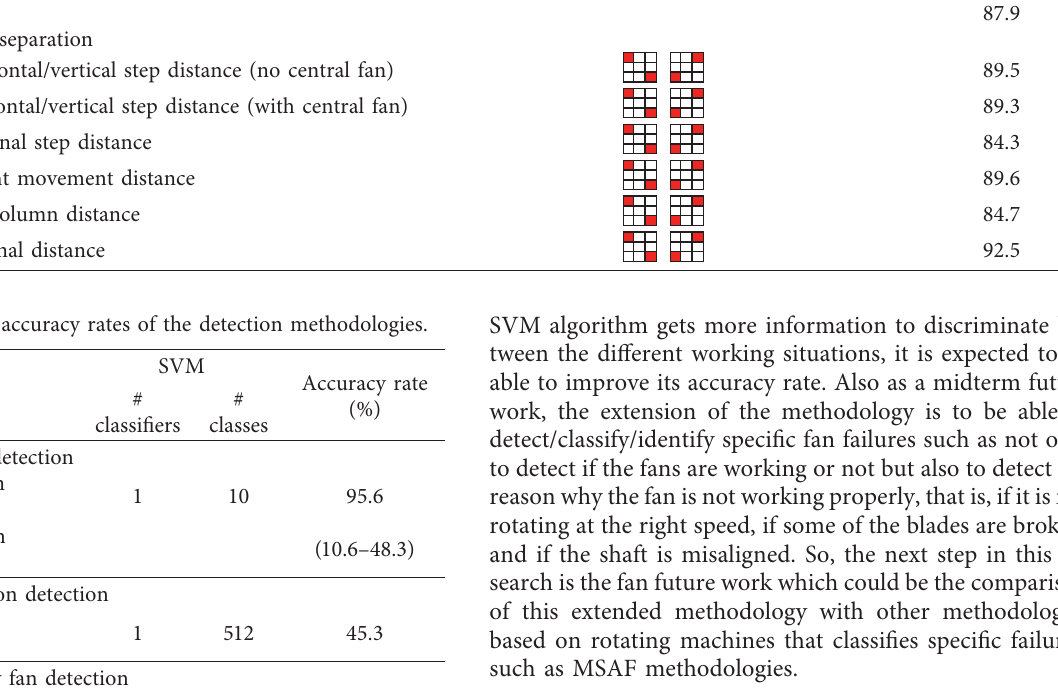
Table 3: SVM accuracy rates of the individual faulty fan detection methodology with two faulty fans working situation of the matrix. Individual faulty fan detection methodology: two faulty fans tests